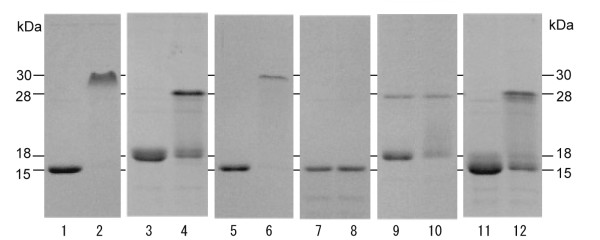
Electrophoretic mobility of wild-type and mutant TC14s on SDS-PAGE. Odd lanes and even lanes show heat-denatured samples and non-heated samples, respectively. Lanes 1,2, wild TC14-3. Lanes 3,4, wild TC14-2. Lanes 5,6, TC14-2(21-60)/TC14-3(61-145). Lanes 7,8, TC14-3F65D. Lanes 9,10, TC14-3T69R. Lanes 11,12, TC14-2R69T.